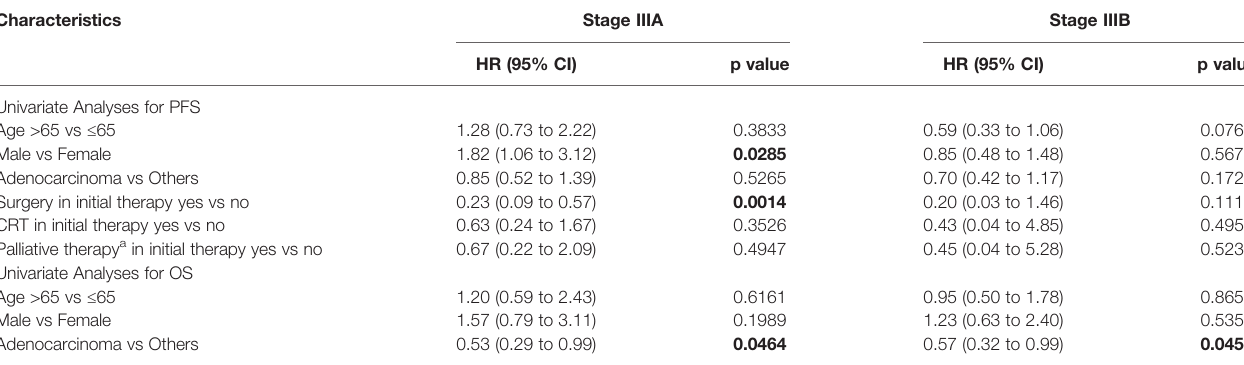
TABLE 4 | Univariate analyses for survival outcomes in stage III NSCLC in Vietnam based on clinico-demographic characteristics and treatment regimen (7 th Edition AJCC).